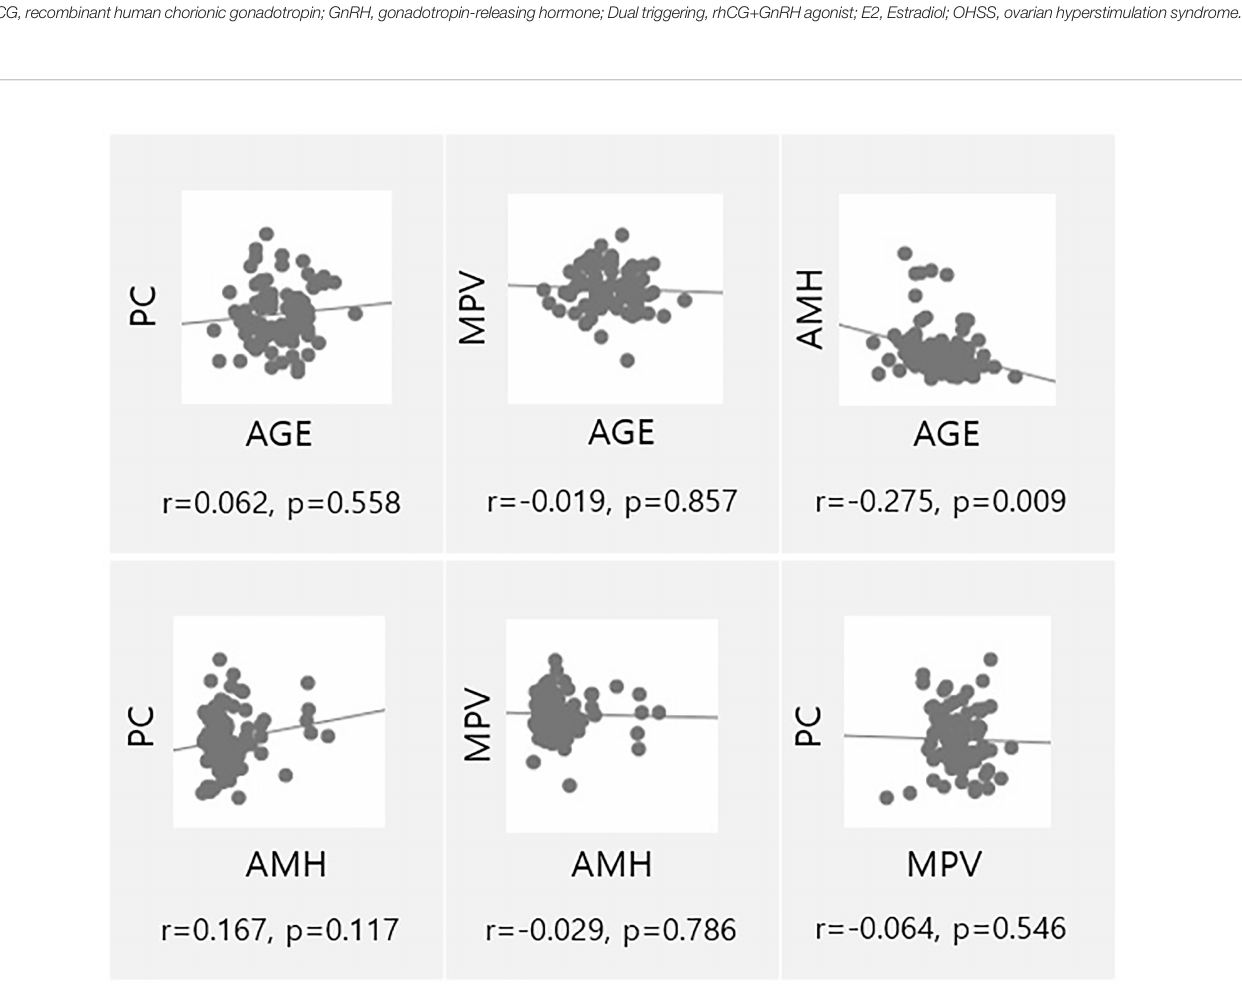
- Data are shown as either Mean ± SD or N (%).